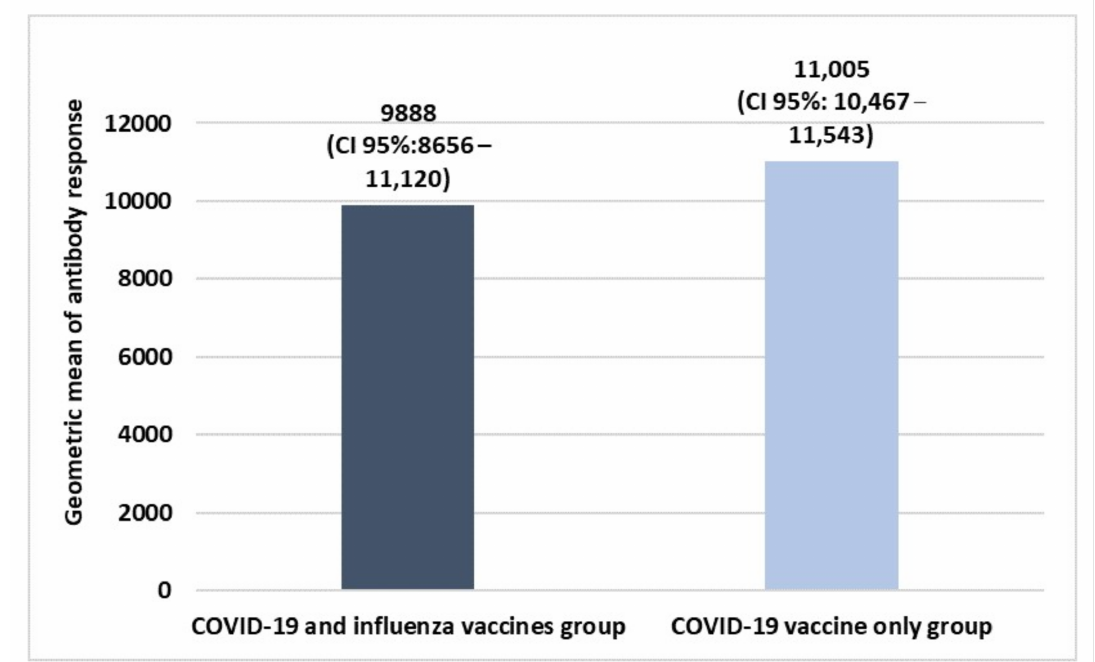
Figure 1. Difference in the immune response to the 1st booster dose of the COVID-19 vaccine between COVID-19 and influenza vaccines and COVID-19 vaccine-only groups. Size sample of both the two groups: 64 HCWs. Student’s t -test was used to evaluate statistically significant